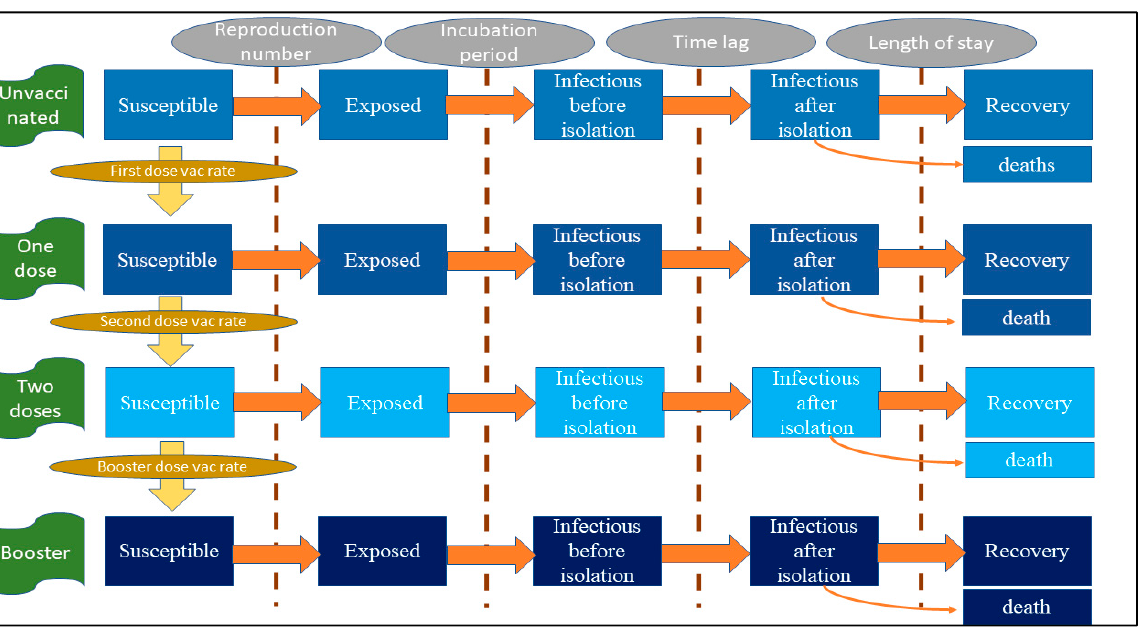
Figure 1. Model framework.